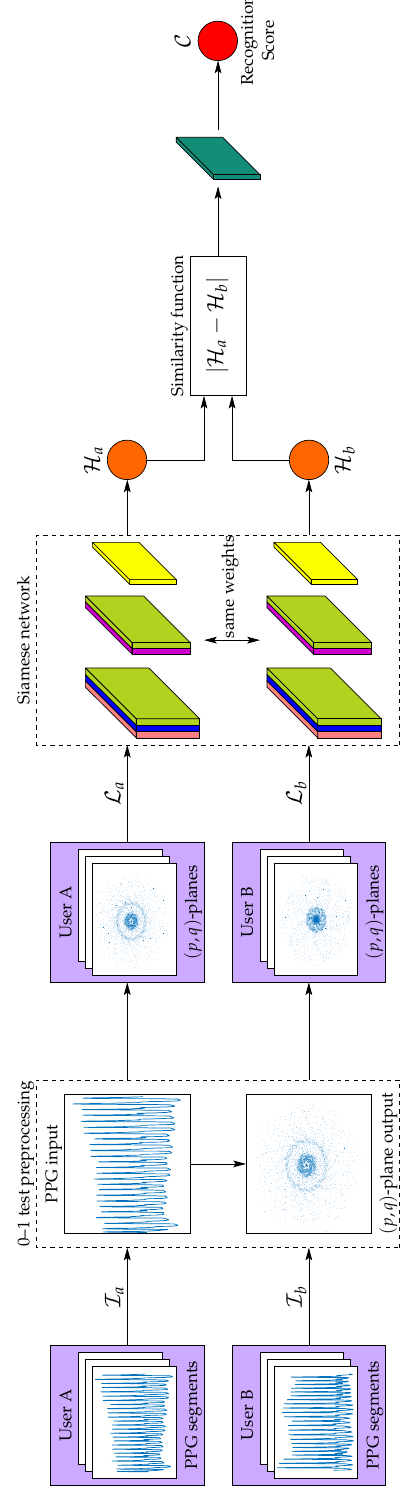
Figure A1. System architecture schematic overview (zoomed view of Figure